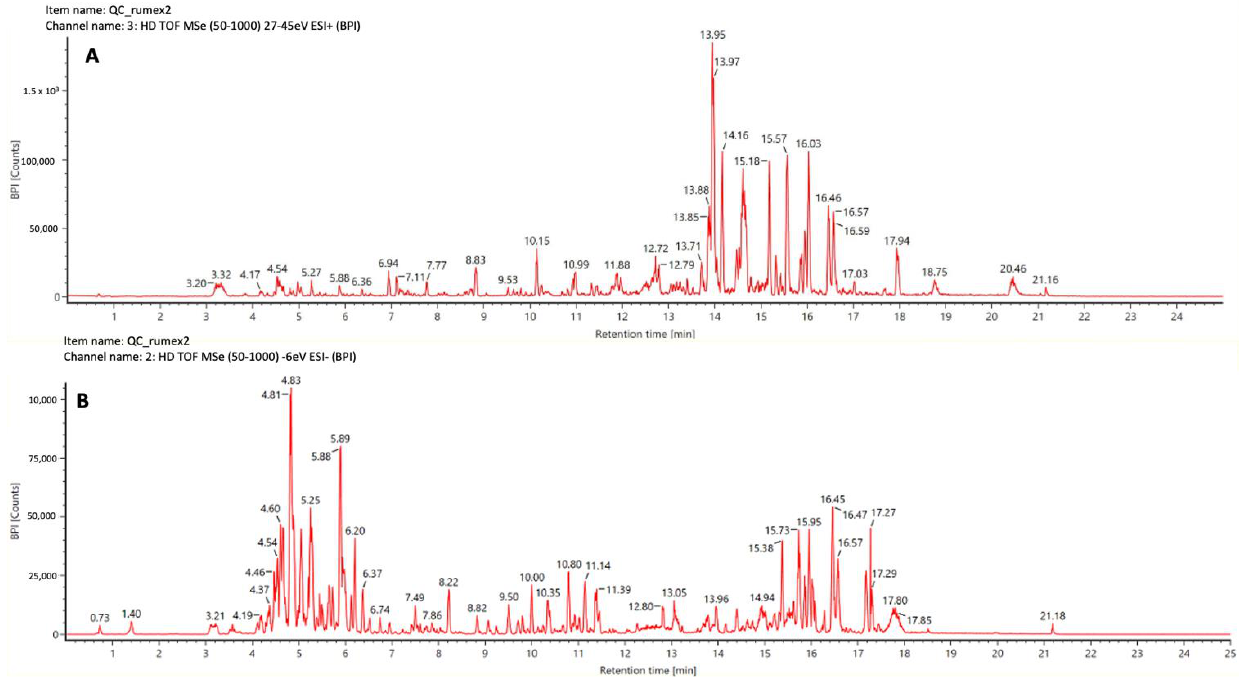
Figure 1. Ultra-high performance liquid chromatography coupled to high resolution tandem mass spectrometry base peak chromatograms of QC pool of Rumex usambarensis extract obtained using positive ( A ) and negative ( B ) ionization modes.